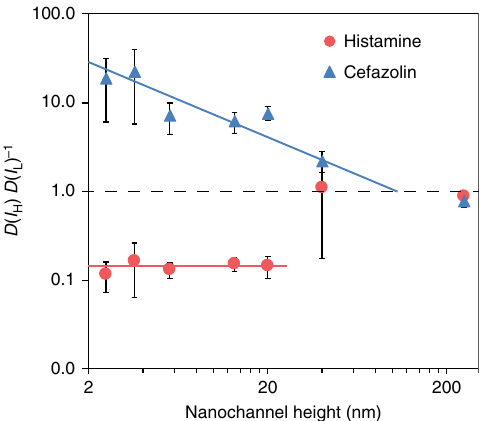
Fig. 5 Drug diffusion in high and low ionic strengths bulk solutions. Ratio between effective diffusivities obtained for histamine (solid dots) and cefazolin (solid triangles) at high (137 mM NaCl, I H ) and low (deionized water, I L ) ionic concentration for each nanochannel size. Each of the data points denotes the average of three individual replicates, error bars